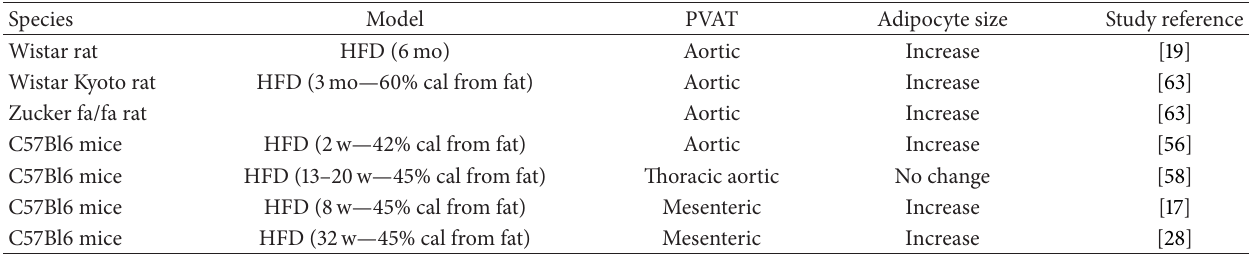
Table 3: Increase in PVAT amount and adipocyte size in different models of